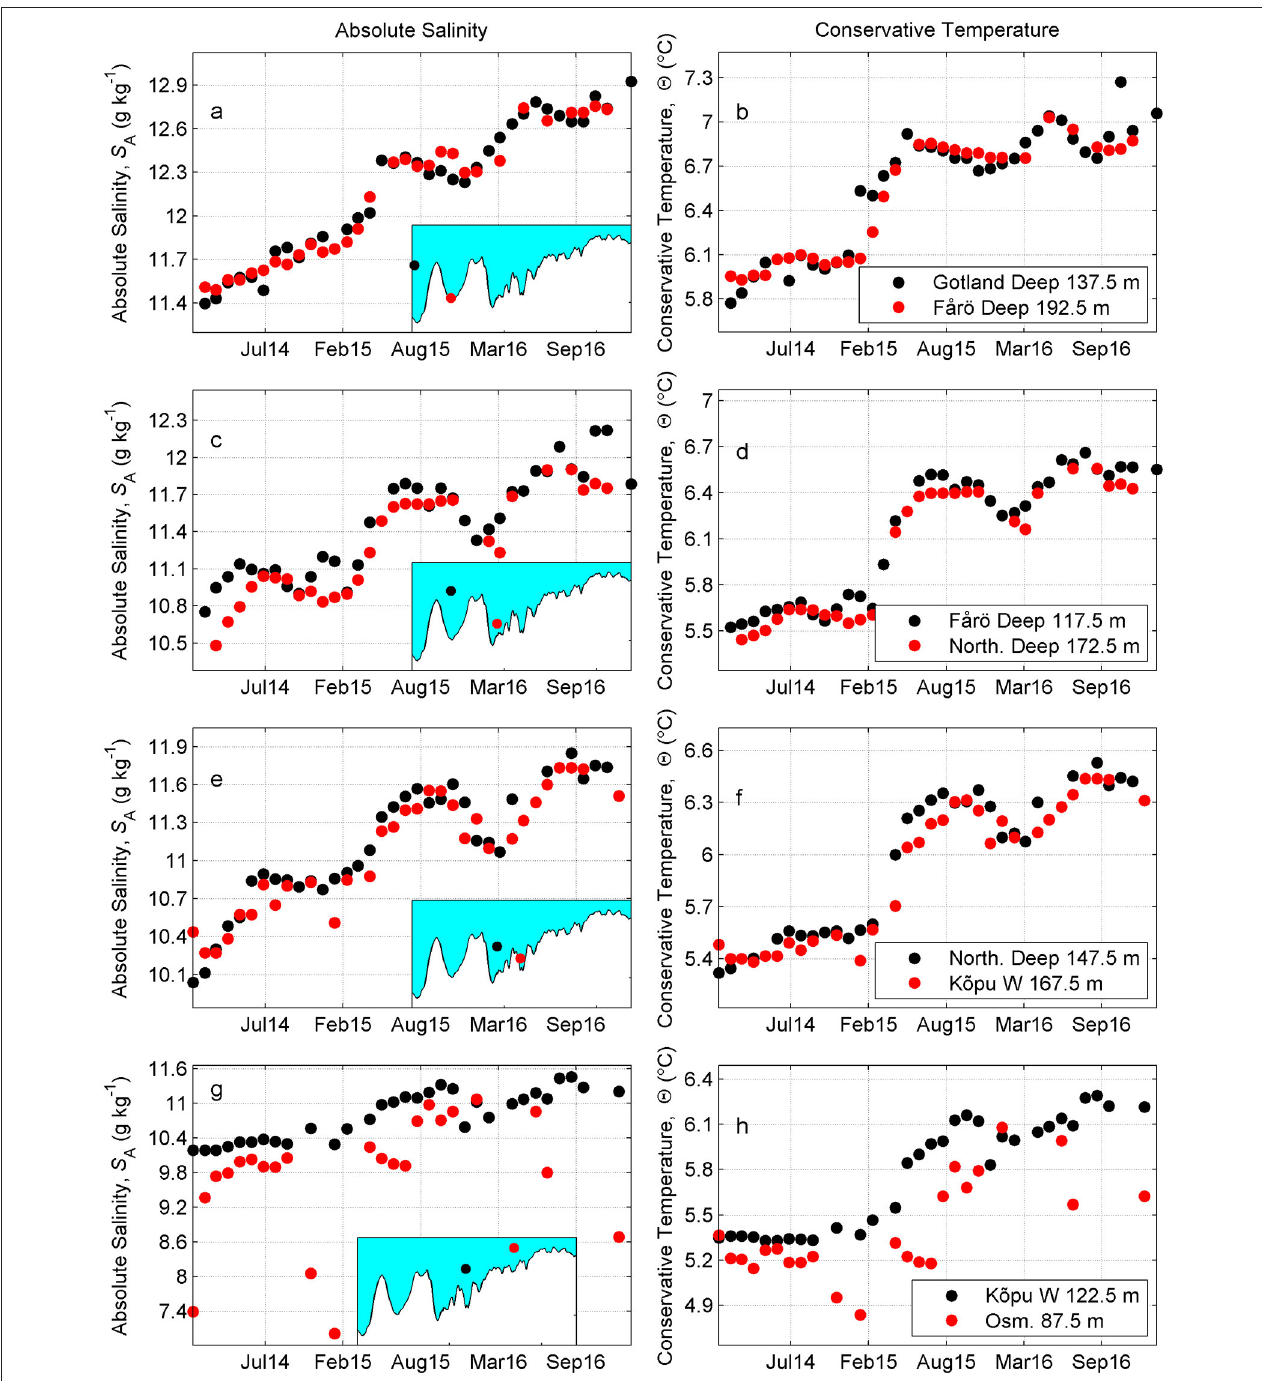
FIGURE 7 | Temporal course of monthly averaged salinity and temperature at the selected depths along pathway in the Gotland Deep (a, b) , Fårö Deep (a-d) , Northern Deep (c-f) , Kõpu West (e-h) , and Osmussaar (g,h) .